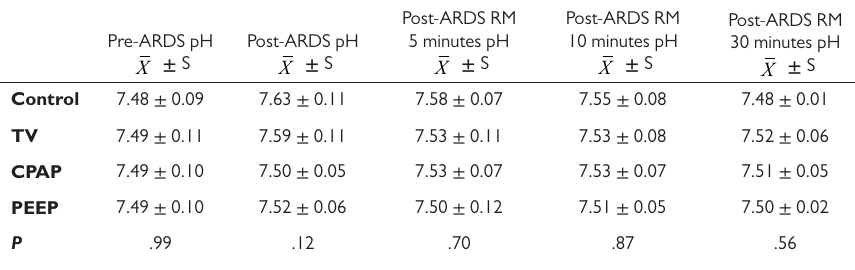
Table 4. Distribution of Mean pH Values of the